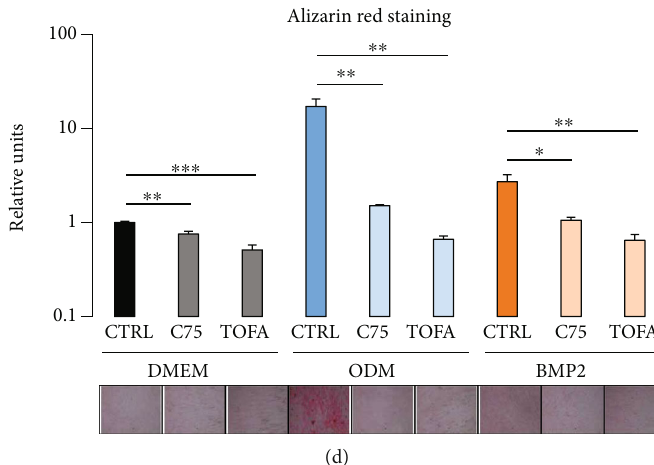
Figure 7: Regulation of osteogenic di ff erentiation in DFCs after inhibition of fatty acid synthesis. DFCs were cultured in osteogenic di ff erentiation medium (ODM), BMP2 di ff erentiation medium, or control medium (DMEM) and simultaneously treated with 5 μ g/ml fatty acid synthesis inhibitors TOFA or C75 or vehicle control for di ff erent time periods before evaluation of osteogenic di ff erentiation markers: (a, b) Gene expressions of COL1A2 (a) and RUNX2 (b) relative to gene expression of GAPDH were determined after three days treatment by RT-qPCR. (c) Activity of alkaline phosphatase (ALP) relative to total protein was measured after seven days treatment. (d) Mineralization of extracellular matrix was determined by Alizarin Red staining after 28 days treatment. Photographic pictures of the staining are shown below the bar chart which shows the relative quanti fi cation results as means + standard deviation . Student ’ s t -tests were performed to compare inhibitor treatment with the vehicle control. ∗ p < 0 : 05 , ∗∗ p < 0 : 01 , ∗∗∗ p < 0 : 001